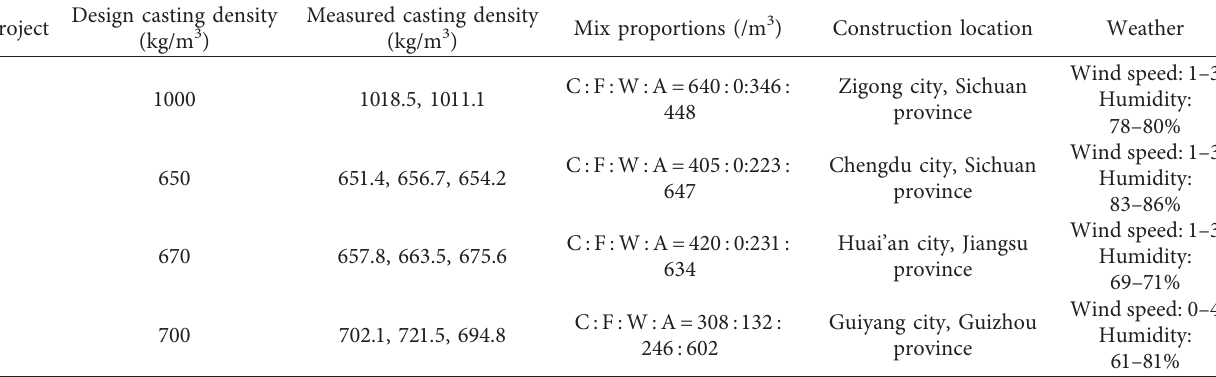
Table 2: Details of the projects.